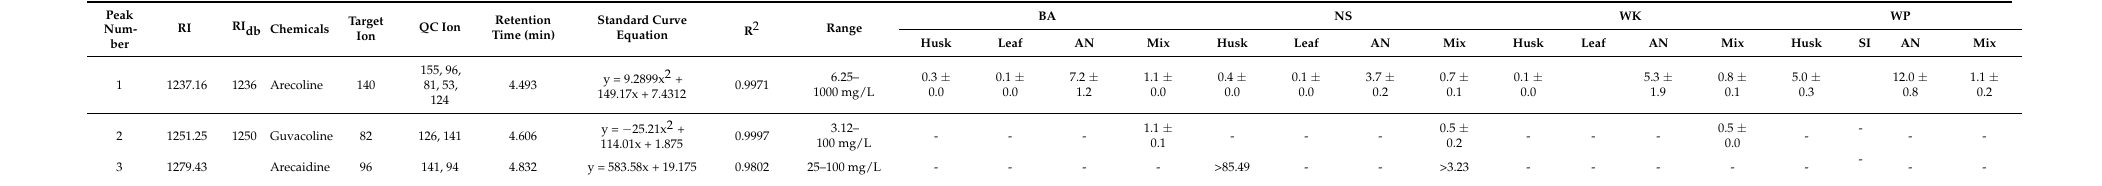
mg/g DM for arecoline and mg/100 g DM for guvacoline and arecaidine; RI, retention index experimental; RIdb, retention index